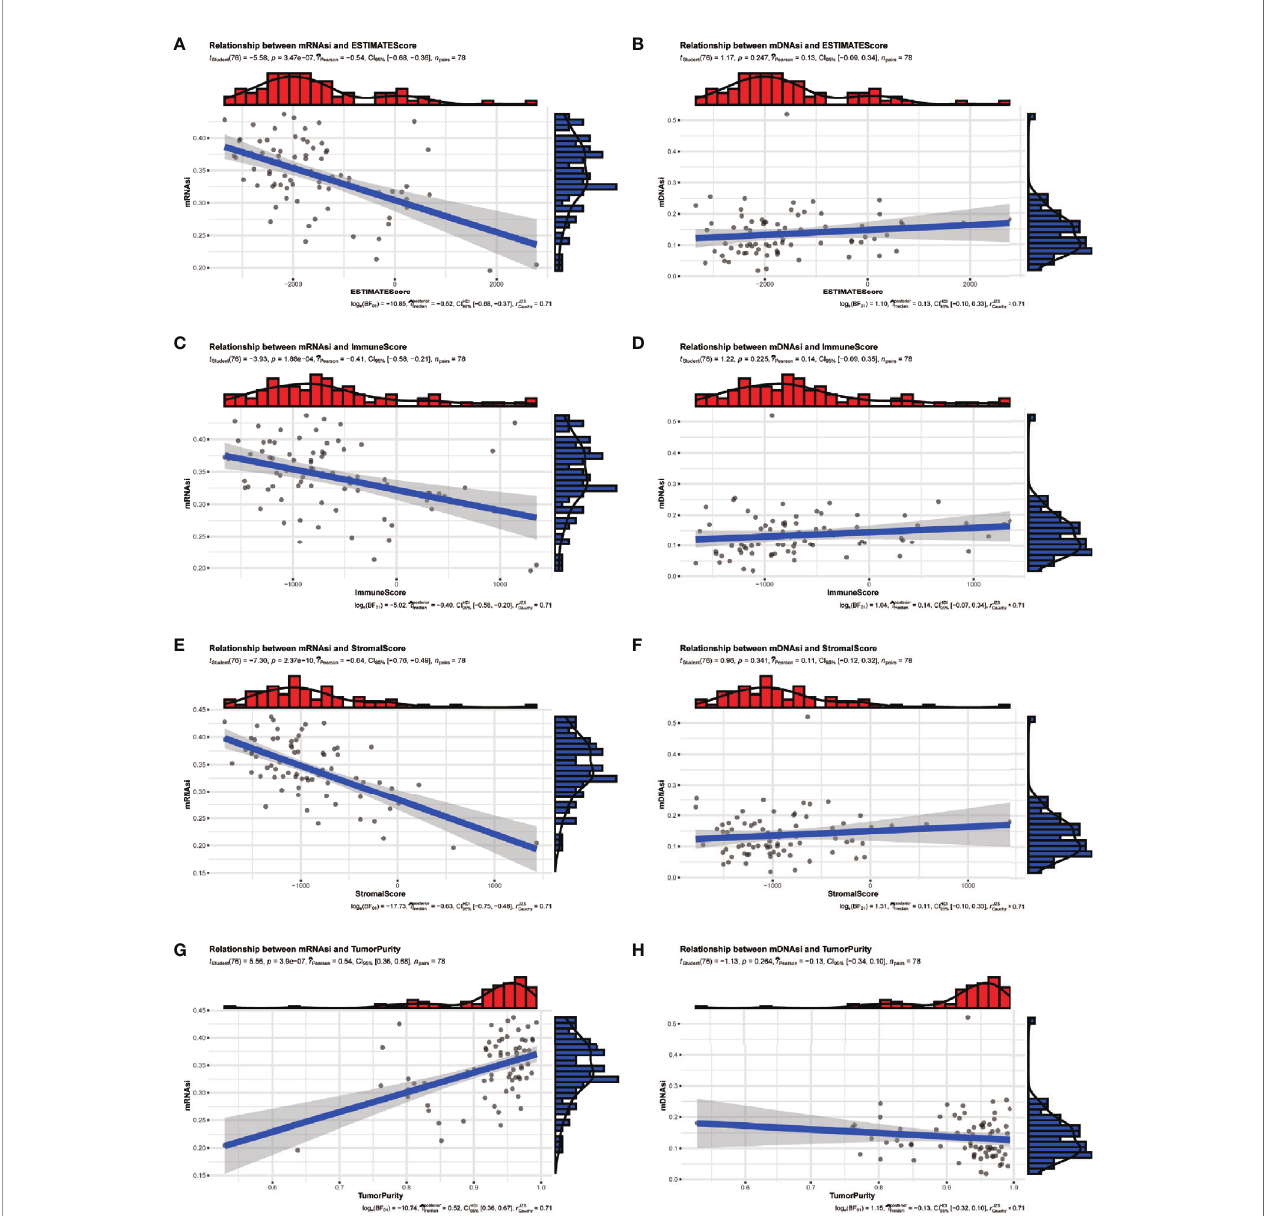
FIGURE 2 | The relationship between stemness indexes (mRNAsi and mDNAsi) and immune microenvironment in ACC patients. (A, B) Correlation between ESTIMATEScore and mRNAsi (A) , mDNAsi (B) . (C, D) Correlation between ImmuneScore and mRNAsi (C) , mDNAsi (D) . (E, F) Correlation between StromalScore and mRNAsi (E) , mDNAsi (F) . (G, H) Correlation between TumorPurity and mRNAsi (G) , mDNAsi (H)